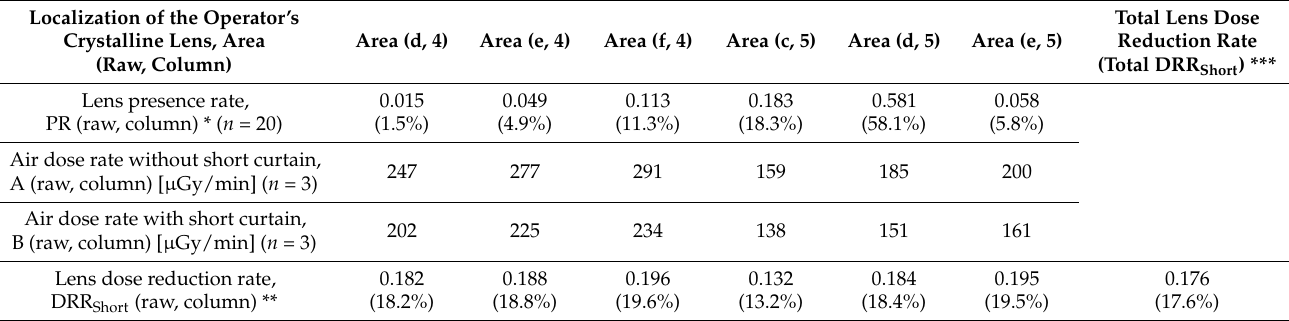
Table 1. Lens dose reduction rate with the short curtain.